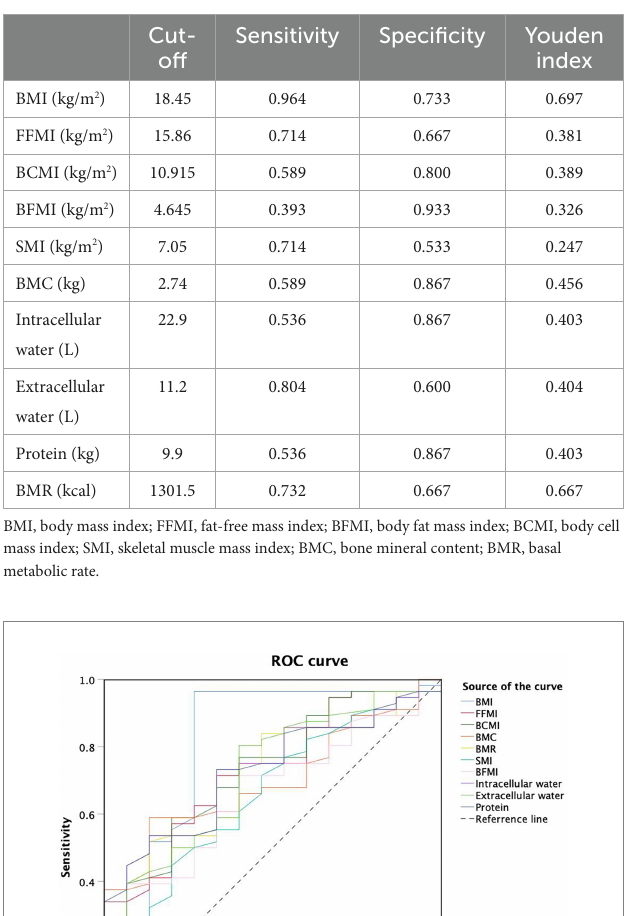
TABLE 5 Cut-off values of body composition for nutritional risk.